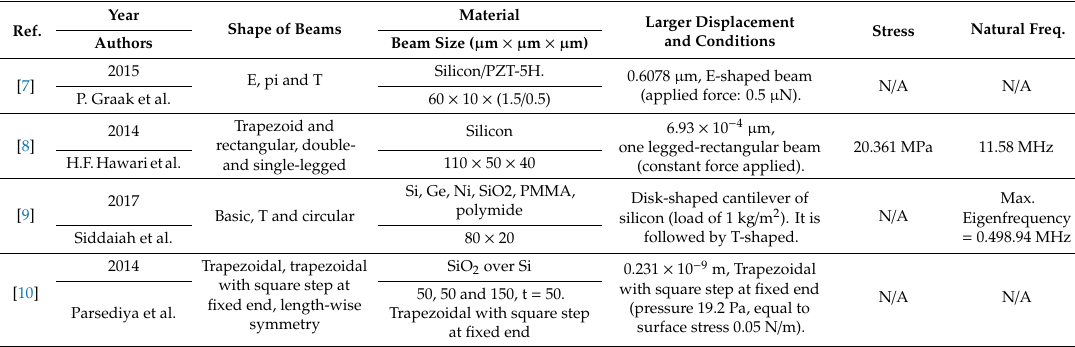
Table 1. Beam shapes and